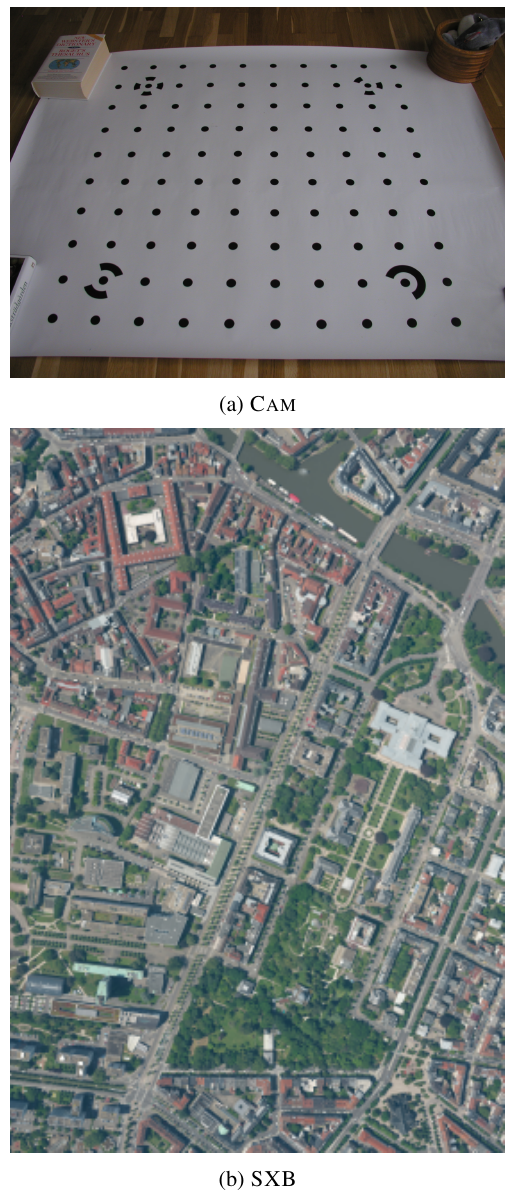
Figure 2. An image from each data set. (a) A close-range image of the PM camera calibration target. (b) An aerial image of the city of